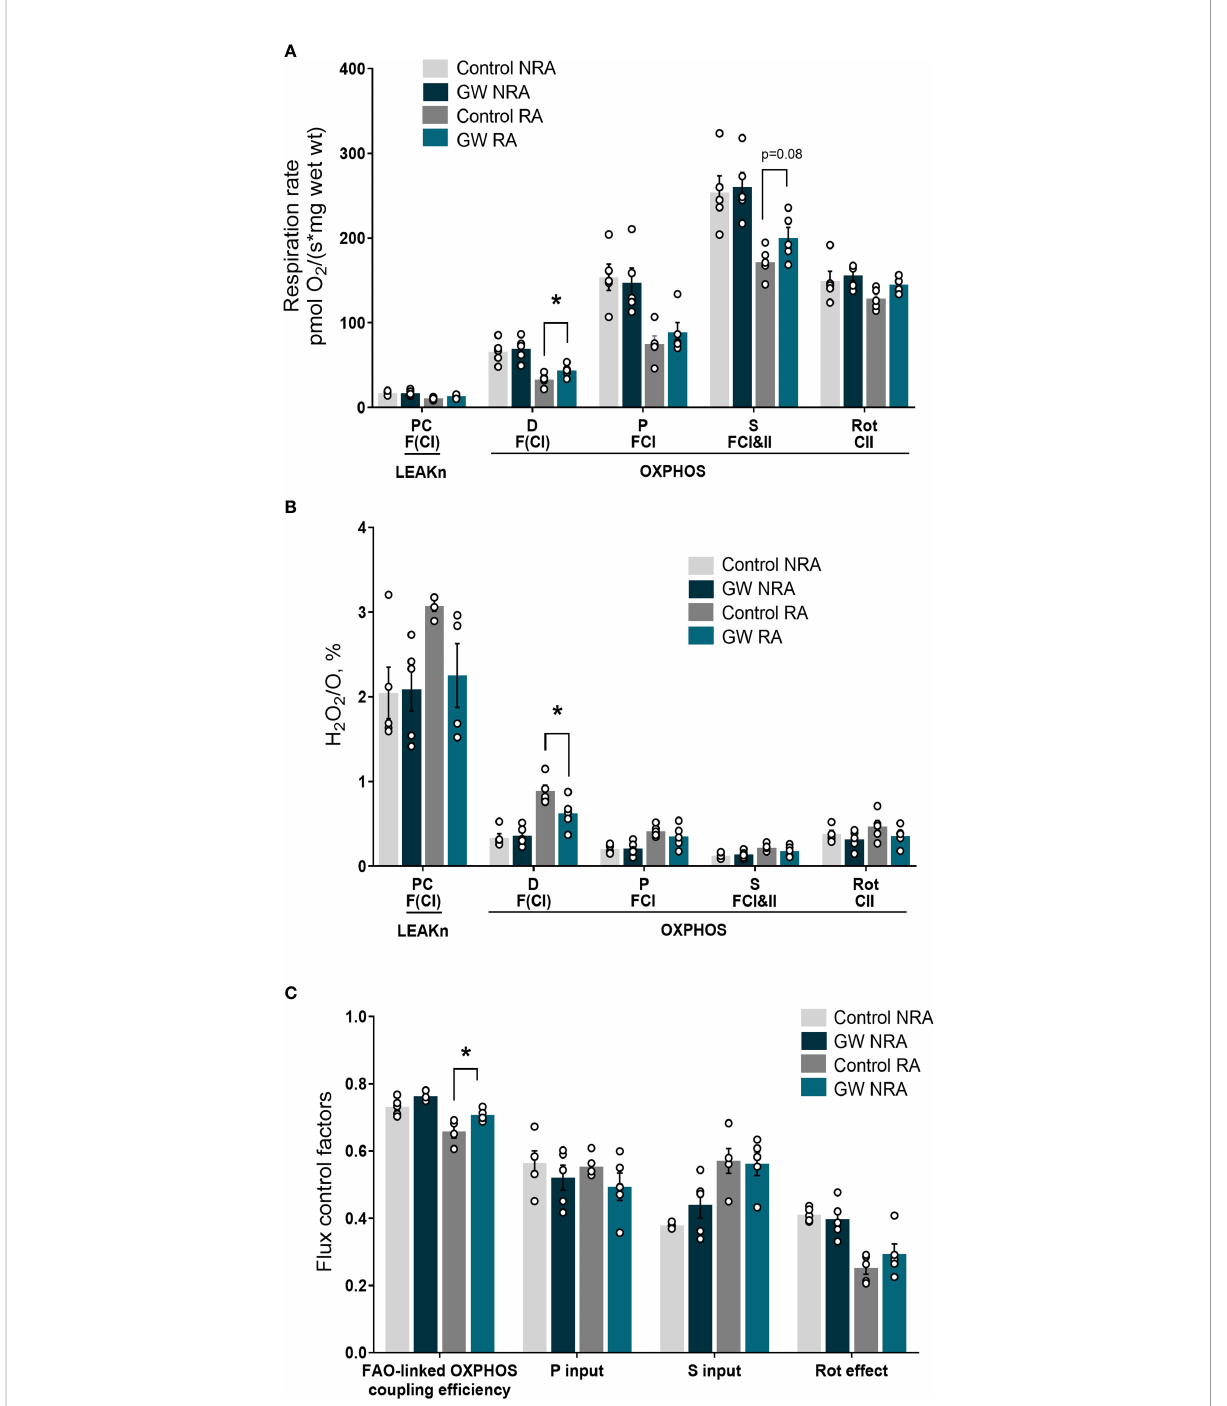
FIGURE 4 PPAR b / d activation improves FAO-dependent mitochondrial bioenergetics in ex vivo I/R. (A) Respiration rate (B) H 2 O 2 % ratio between O 2 fl ow and H 2 O 2 production rate. Fluorescence signals were calibrated using H 2 O 2 titrations at the corresponding state. Data is presented as means ± SEM of 4-6 independent experiments. (C) Substrate fl ux control factors calculated as: (respiration rate after the addition of substrate - respiration rate before the addition of substrate)/respiration rate after the addition of substrate. PC, palmitoyl carnitine; D, ADP; P, pyruvate; S, succinate; Rot, rotenone – complex I inhibitor; RA, risk area; NRA, non-risk area; FAO, fatty acid oxidation; F(N), fatty acid oxidation-dependent pathway (FADH2 and NADH); S, succinate-dependent pathway (FADH2); LEAKn, substrate metabolism-dependent state; OXPHOS, oxidative phosphorylation-dependent state; GW, pretreated with PPAR b / d agonist. *p <